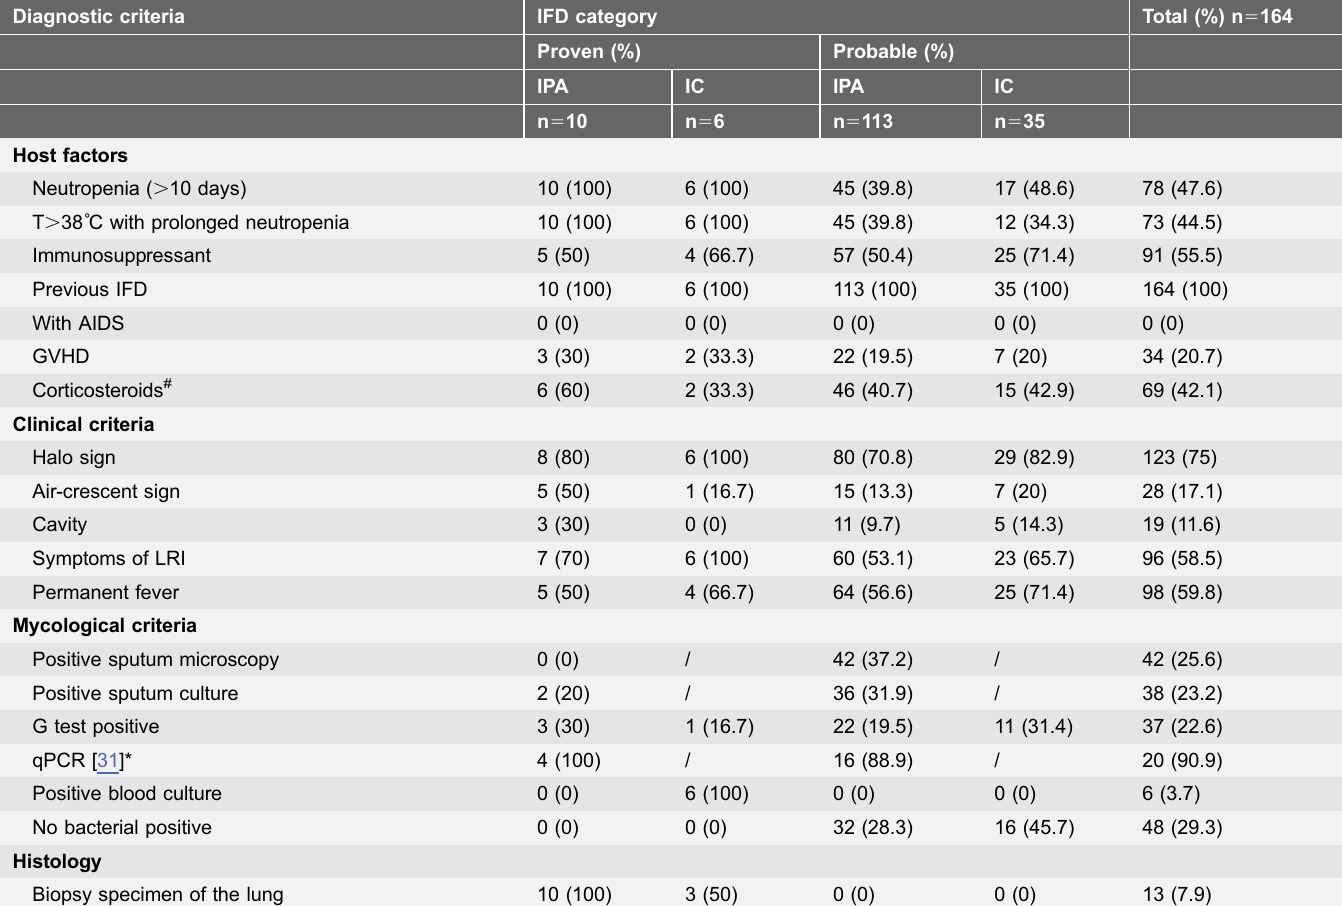
Table 1. Diagnostic criteria and results for 164 patients with previous